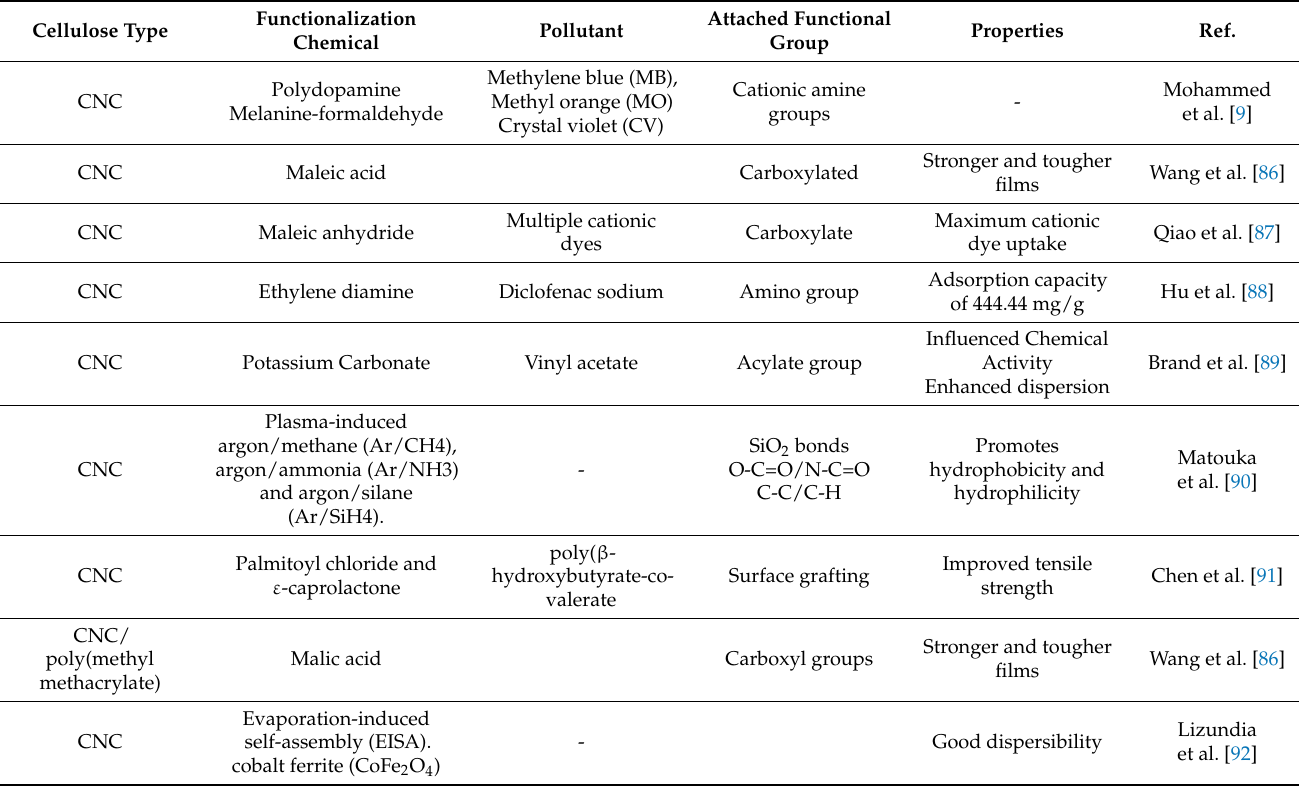
Table 1. Recent studies on the surface chemical functionalization of cellulose nanocrystals and their functional